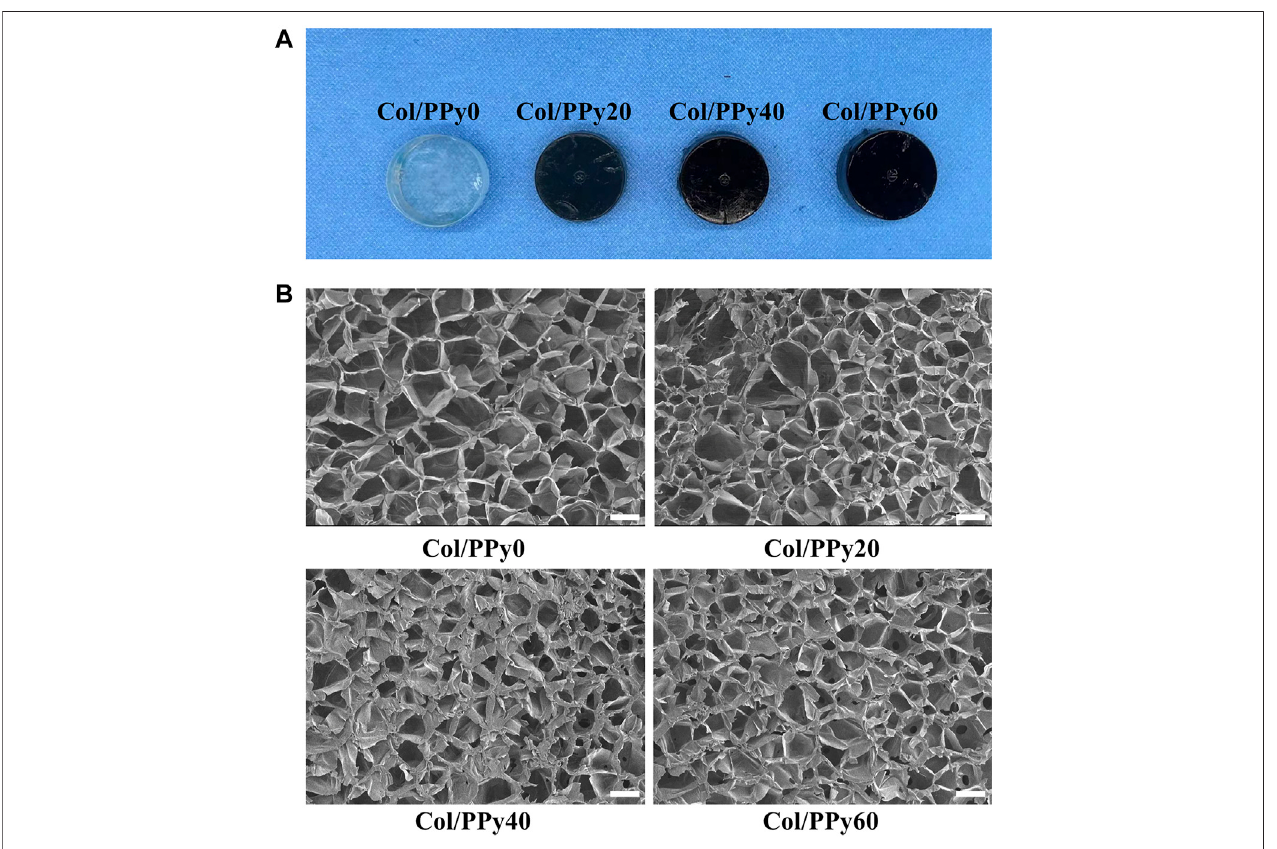
FIGURE 1 | (A) Photographs of the various Col-PPy hydrogels; (B) SEM images of various Col-PPy hydrogels, scale bar 100 mm.